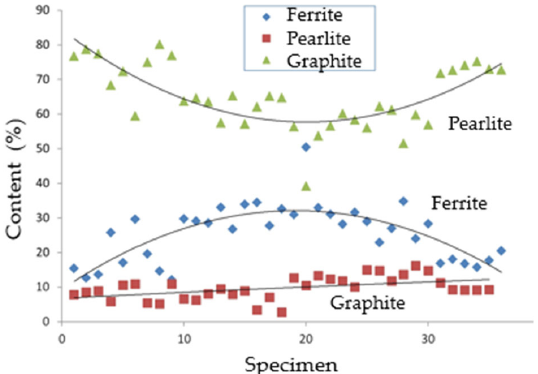
Figure 5. Ferrite, pearlite and graphite contents with respect to each specimen.